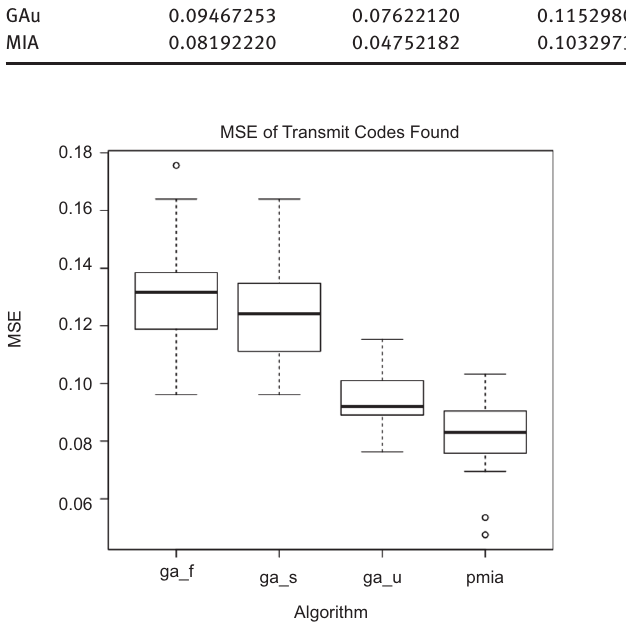
Figure 6. Length 49 64 PSK Box Plot Results.